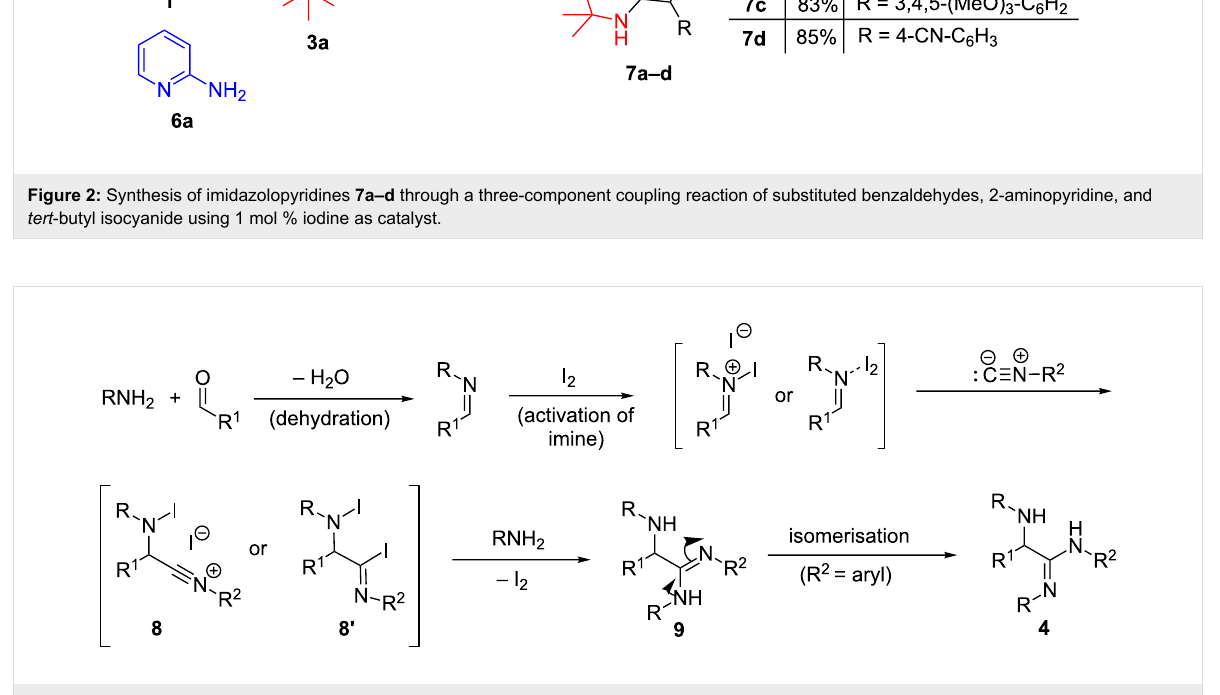
Figure 3: A plausible reaction mechanism for the iodine-catalyzed α -amino amidine